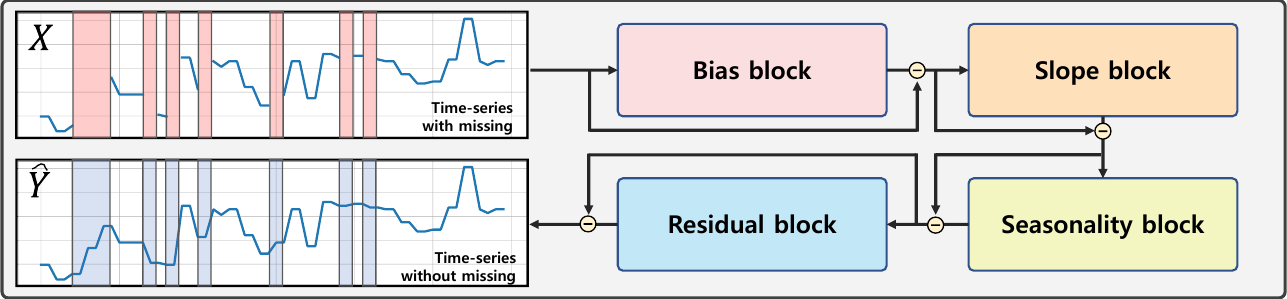
Figure 2. Overview of proposed model. X and ˆY indicate the input and output time-series of the model, respectively. At first, the bias block estimates the average value of the non-missing values h bias